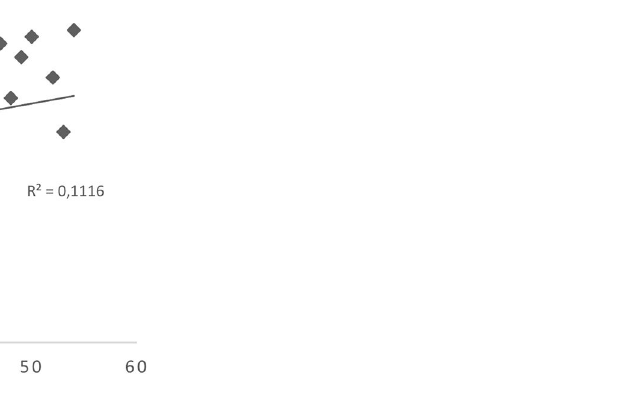
Figure 1. Scatterplot showing the relationship between rumination scores and scores on the guilt-fear of failure day- dreaming category, N = 31.